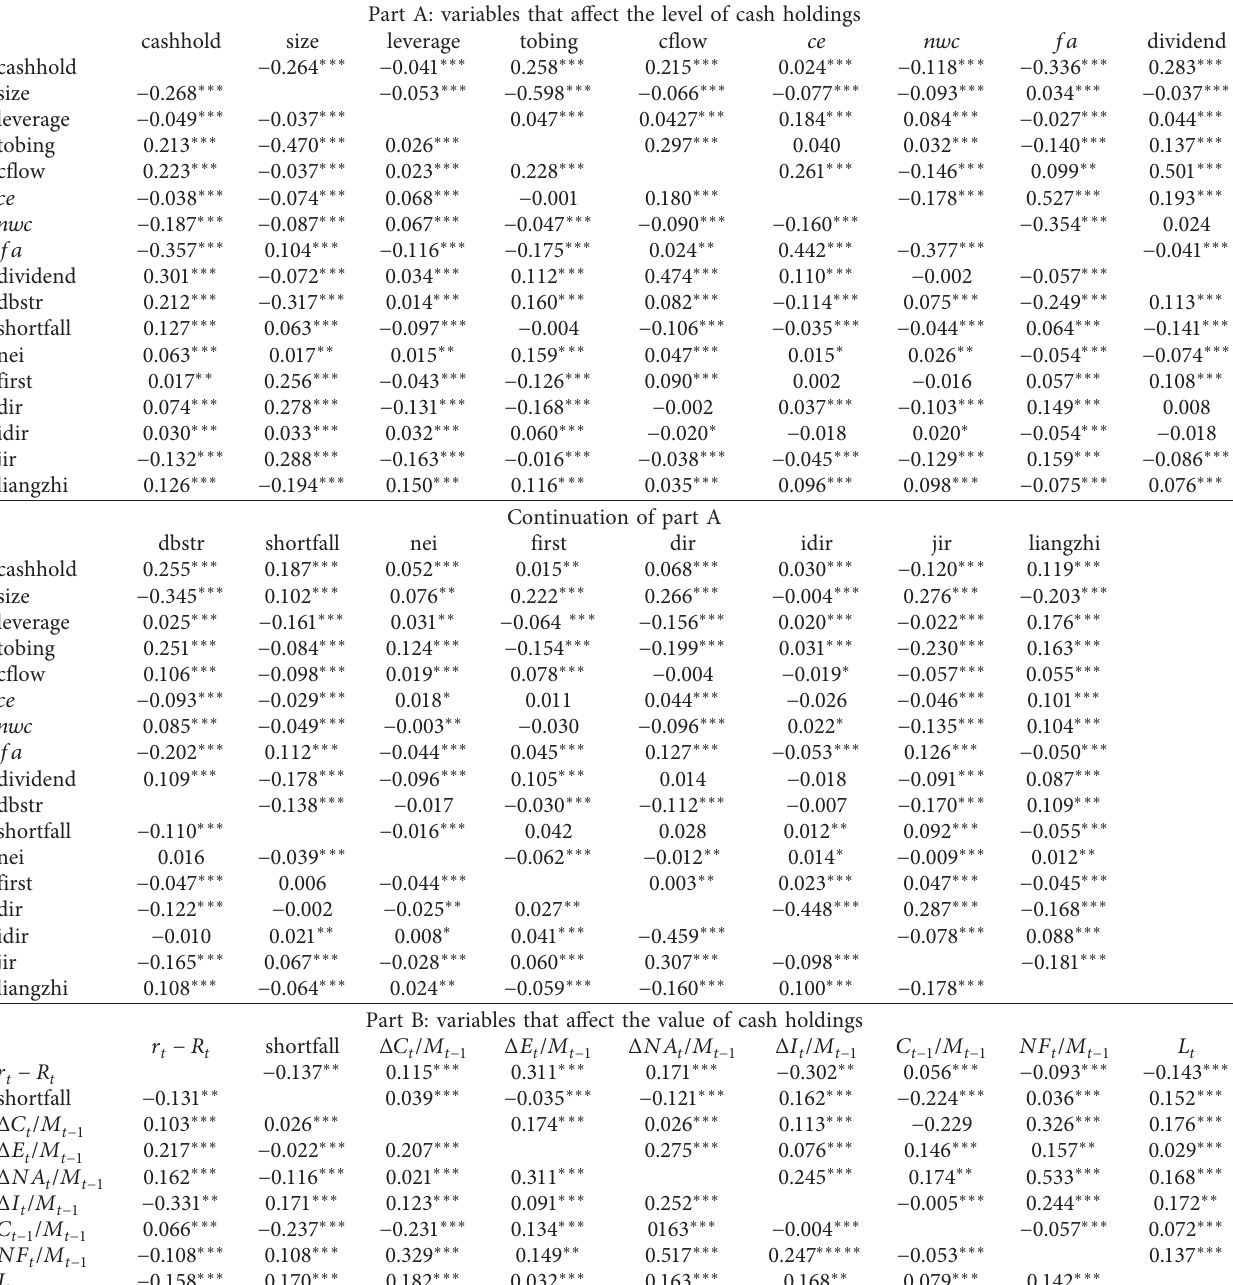
Table 3: Test of correlation coefficients of major variables (Pearson and